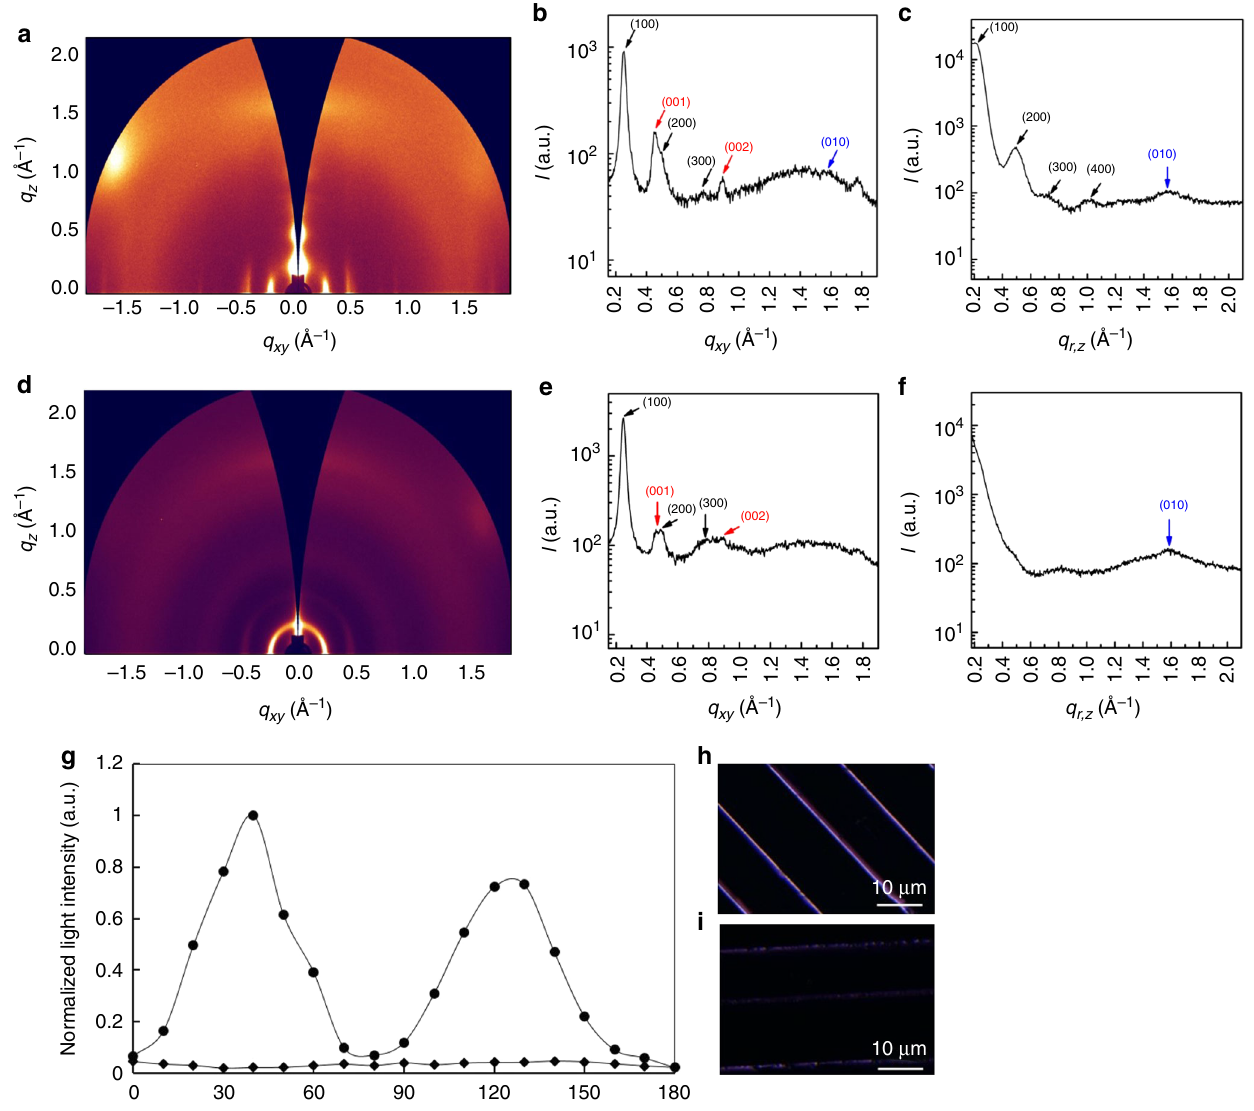
Fig. 4 Evaluation of the patterned wires. GI-WAXD results for a spun-cast P(NDI2OD-T2) fi lm ( a – c ) and patterned P(NDI2OD-T2) wires ( d – f ). b , c The in- plane and out-of-plane data of the spun-cast sample, respectively, while e and f are the in-plane and out-of-plane data of patterned wires taken in the wire direction. Both devices were annealed at 140 °C for 30 min. Angle dependence of the brightness of patterned P(NDI2OD-T2) lines ( g ) measured under polarized microscope for samples created using our patterning method (solid circles) and by plasma etching a spin-coated P(NDI2OD-T2) fi lm with PVP lines as a mask (solid diamonds). h , i Birefringence images of wires with different orientations around 45° and 180°,